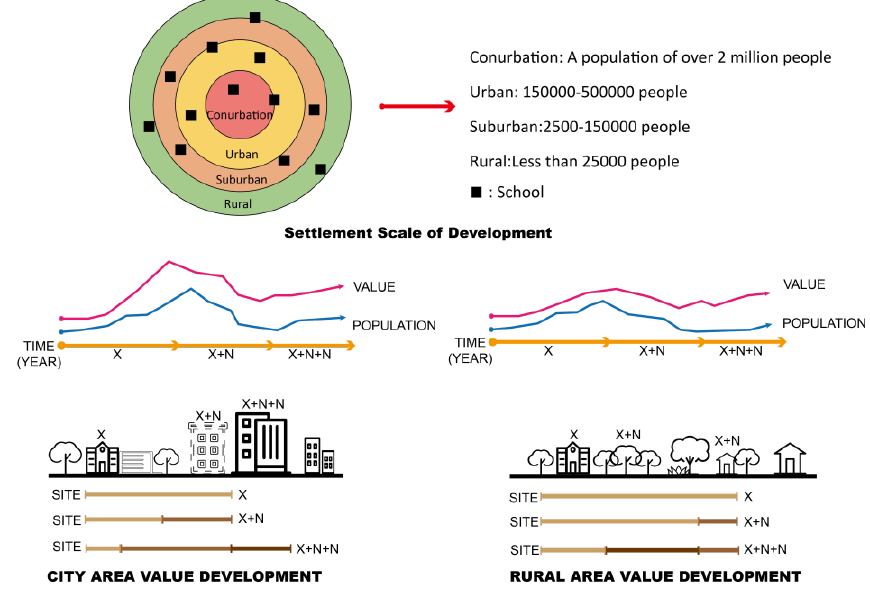
Figure 1. The Social Value of School Transformation.